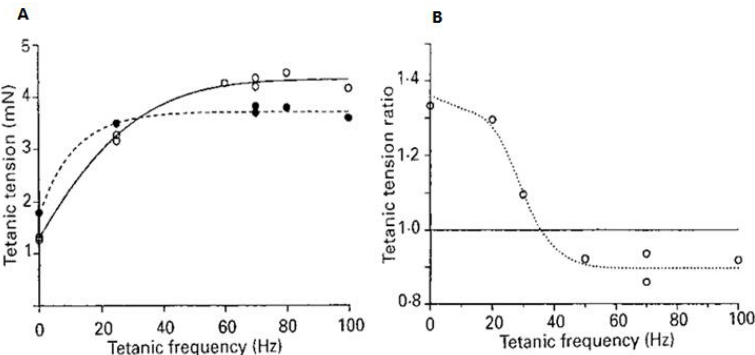
Figure 9. ( A left), Stimulation frequency versus tension at atmospheric pressure ( ○ ) and at a higher pressure (5 MPa, ● ) from one fibre bundle (width 300 µm). ( B right), From another fibre bundle, tetanic tension recorded at 10 MPa plotted (as a ratio of that at atmospheric pressure) against frequency; data at frequency 0 Hz represent twitch (adapted from Ranatunga and Geeves, [18]).